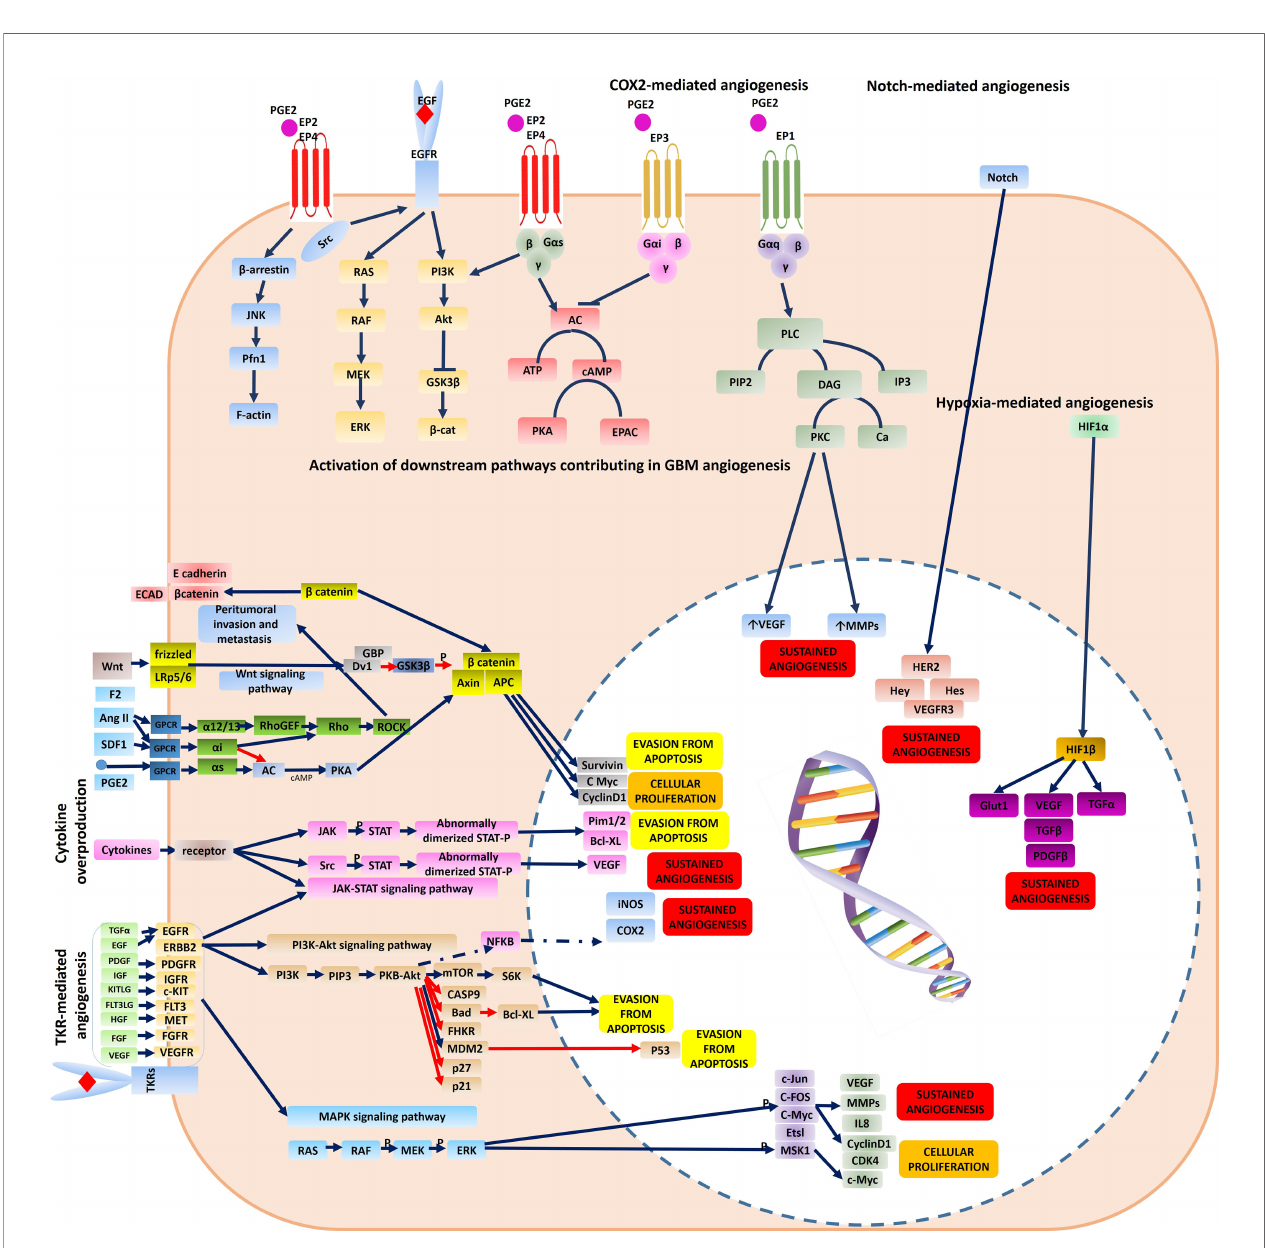
FIGURE 2 | Molecular mechanisms contributing to tumor angiogenesis and resistance to anti-angiogenic therapy in a GBM cell. The major molecular pathways responsible for GBM angiogenesis comprise: (1) TKR-mediated angiogenesis via activation of downstream signaling pathways (PI3K-Akt signaling pathway, and MAPK signaling pathway) (2) cytokine-mediated angiogenesis via activation of downstream signaling pathways (JAK-STAT signaling pathway) (3) SDF1, ANG2 as compensatory mechanisms (4) Hypoxia-mediated angiogenesis via activation of HIF1 a signaling pathway (5) COX2-mediated angiogenesis via activation of G- protein- coupled receptors mediating activation of protein-kinase C (PKC) and also its interactions with EGFR signaling (6) Notch-mediated angiogenesis. Some of the vectors used to design this fi gure were downloaded from Vecteezy under a free